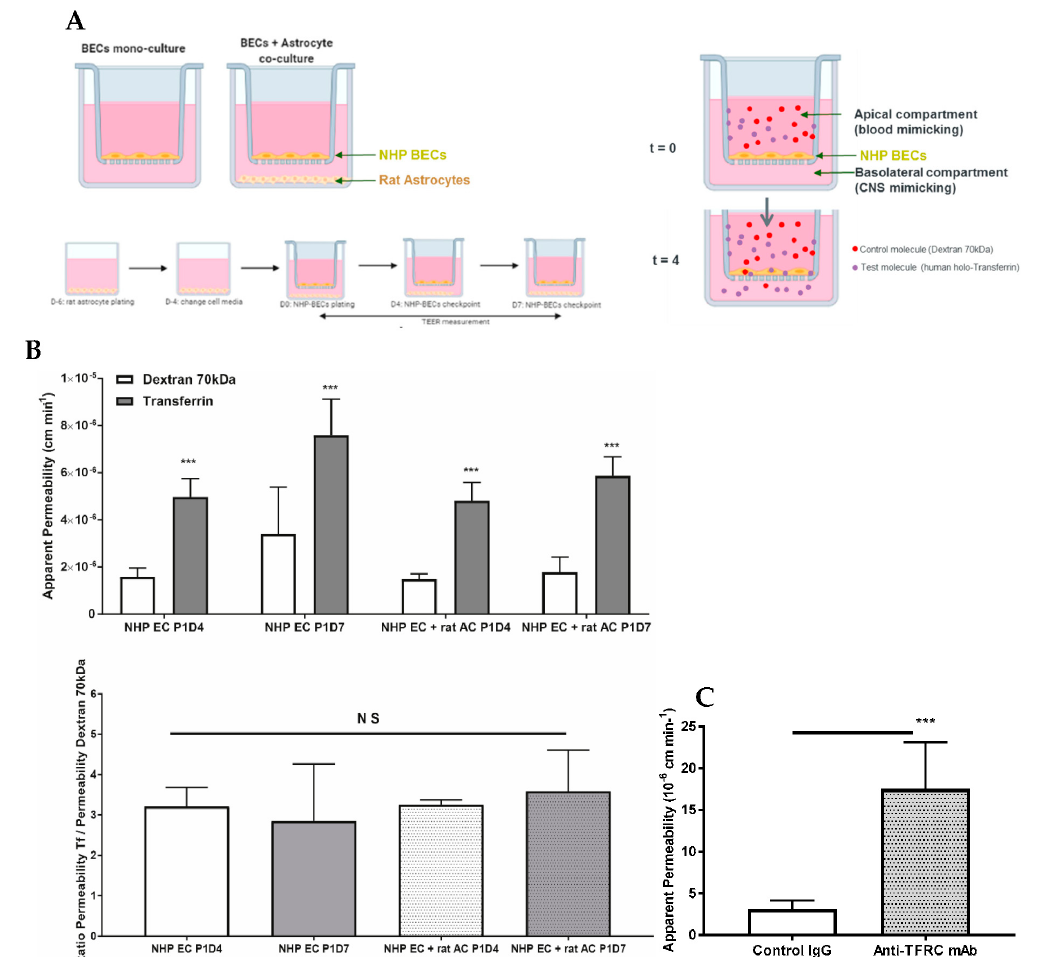
Figure 7. Proof of concept of the use of the present NHP-derived BBB model for evaluation of the apical to basolateral passage of selected molecules. ( A ) Schematic representation of the set-up of NHP-derived BBB model. NHP-derived BECs at P1 are plated on the insert, and rat astrocytes are optionally plated at the bottom of the well. Plating of rat primary astrocytes is performed 6 days before BECs are plated onto collagen and fibronectin-coated membrane filter inserts. This model is used at P1 following either 4 or 7 days in vitro. At the beginning of the assay, test molecules (human holo-transferrin and dextran 70 kDa) were incubated apically for 4 h at 37 ◦ C. After 4 h, media from the apical and basolateral chambers were collected to assess paracellular flux (dextran 70 kDa) or transcytosis (transferrin). Such molecules present in the media from the apical and basolateral chambers were quantified by fluorescence or by IgG ELISA. ( B ) Permeability (10 − 6 cm min − 1 ) from apical to basolateral passage of human holo-Transferrin (Tf) versus Dextran 70 kDa measured in the NHP BBB model. This model was used at P1 following either 4 or 7 days in vitro (P1D4 and P1D7, respectively) in the absence or presence of primary rat astrocytes (control and + rat AC, respectively). Results are expressed as mean ± S.D. ( n = 3 independent experiments, performed in triplicate or quadruplicate). p -values were obtained by Two-way ANOVA with Sidak’s multiple comparisons test or One-way ANOVA with Dunnett’s multiple comparison test vs. NHP EC P1D4 group. NS: no statistical significance = p > 0.05, *** = p < 0.001. ( C ) Permeability (10 − 6 cm min − 1 ) from apical to basolateral passage of an anti-TFRC antibody versus a control mouse IgG measured in the NHP BBB model. This model was used at P1 following either 4 days in vitro in the presence of primary rat astrocytes. Results are expressed as mean ± S.D. ( n = 3 independent experiments, performed in quadruplicate). p -values were obtained by Student t -test NS: no statistical significance = p > 0.05, *** = p <